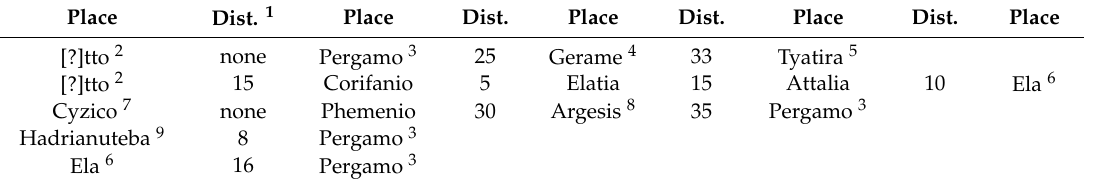
Table 2. Routes mapped in the Tabula Peutingeriana .